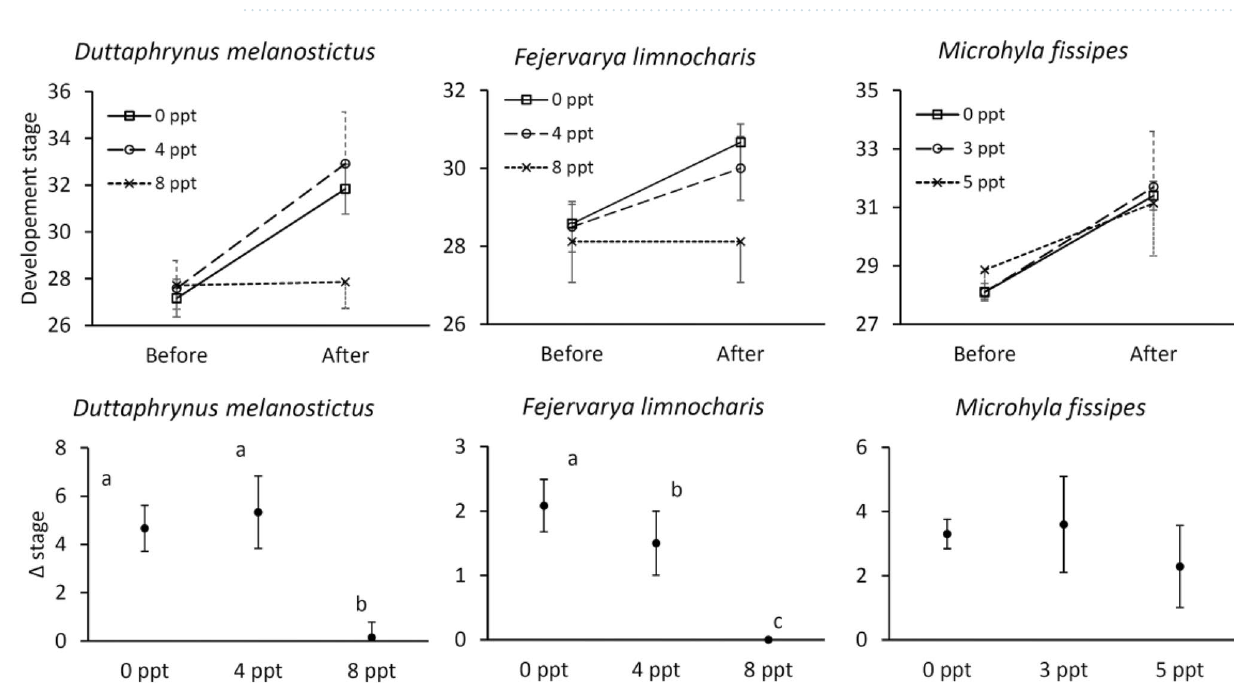
Figure 2. The development of tadpoles under salty water. The difference of developmental stage before and after salinity acclimation of Duttaphrynus melanostictus (left), Fejervarya limnocharis (middle), and Microhyla fissipes (right) tadpoles in freshwater (open square), low salinity (open circle), and high salinity treatments (x-mark). Values of Δ stage with different letters represent a statistical difference (Kruskal–Wallis tests with Dunn posterior tests, p < 0.05) among treatments. Duttaphrynus melanostictus : n = 12, 12, and 7, respectively; Fejervarya limnocharis : n = 12, 12, and 8, respectively; Microhyla fissipes : n = 10, 10, and 7, respectively. Data presented as means ±